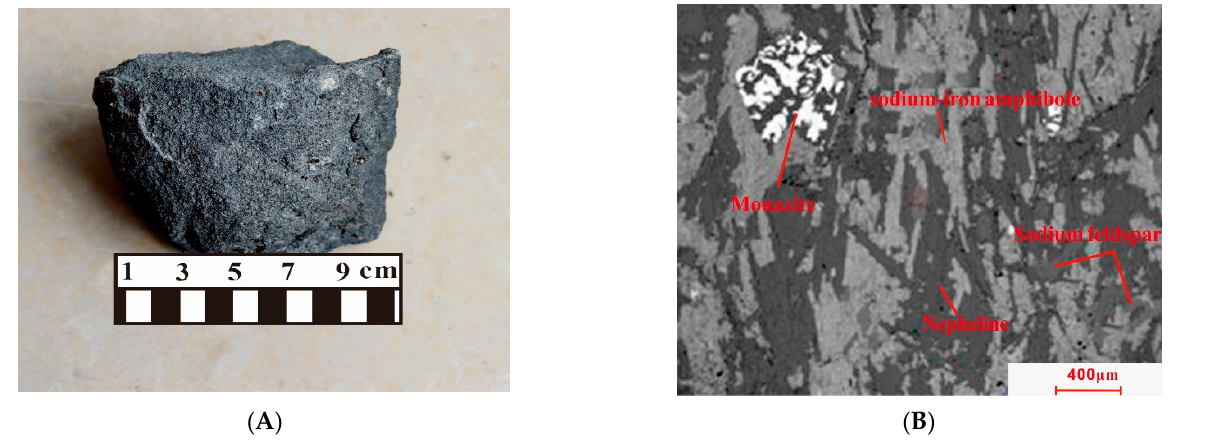
Figure 6. ( A ) Lujavrite hand specimen; ( B ) microscopic photograph of